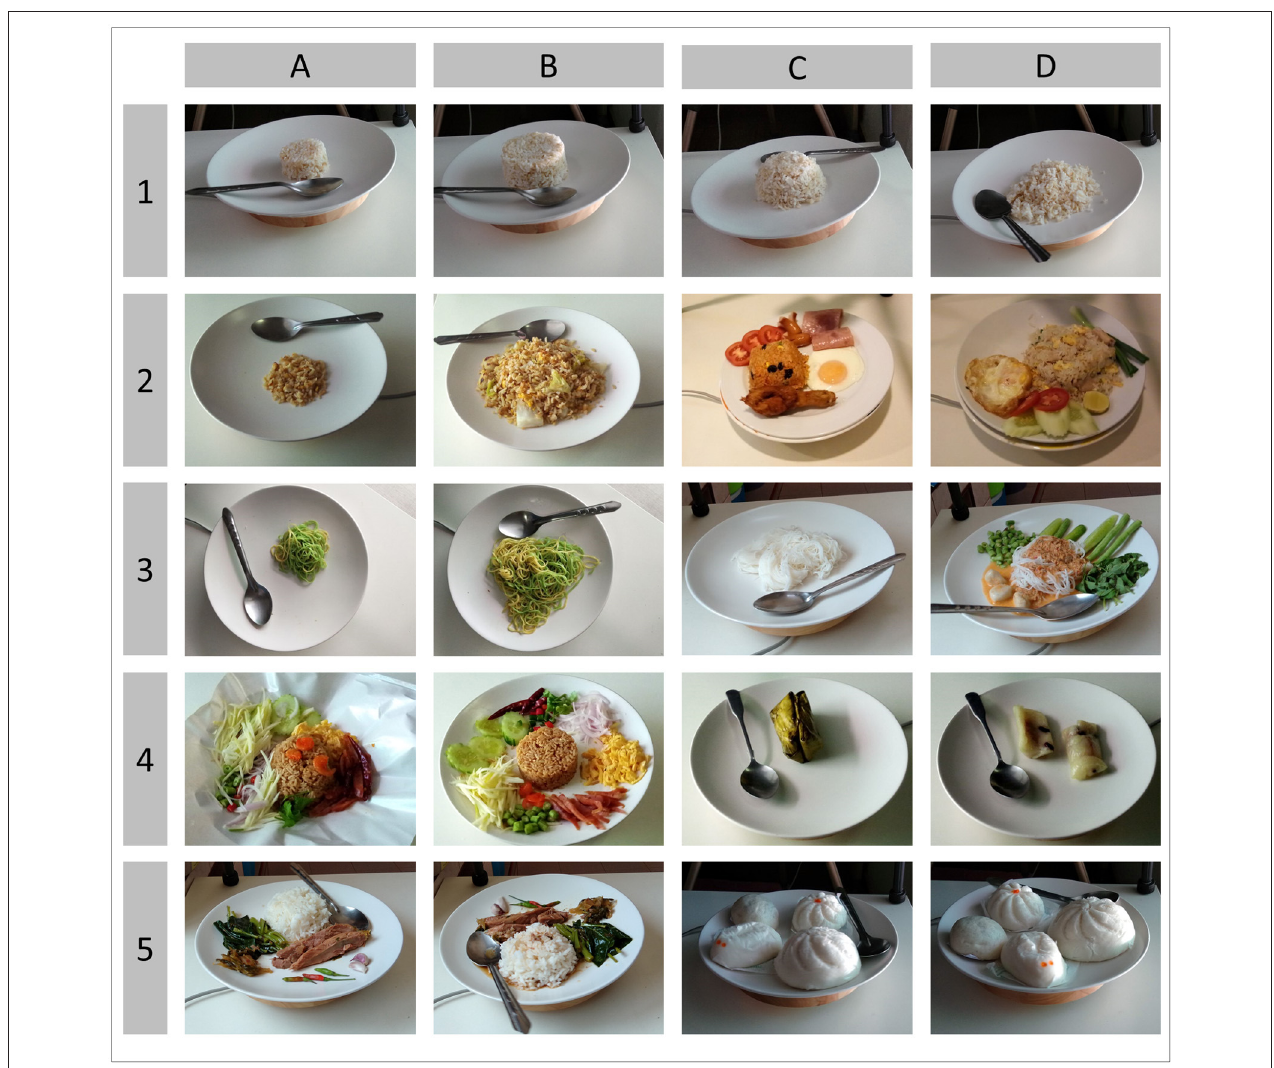
FIGURE 4 | Examples of Thai food images in the newly developed dataset; (A1:D1) represent gradual increases in the portion size of steamed white rice; (A2:D2) represent variation in visual appearance of (A2:B2) fried rice entailing plain fried rice, (C2) fried rice with ketchup and raisins, and (D2) fried rice as provided by food vendors; (A3:B3) are wheat noodles in gradually increasing portion sizes; (C3) is plain Kanomjeen (rice noodle), and (D3) is Kanomjeen topped with Namya-pla (ground fish in spicy coconut milk curry) and vegetables; (A4) is food vender prepared Khao-kluk-kapi (fried rice with shrimp paste), while (B4) is the rearranged form of the food as recommended for carbohydrate counting. (C4) is Kaotom-mud (glutinous rice steamed with coconut milk) wrapped in a banana leaf container, and (D4) is the unwrapped form of the dessert; (A5:B5) are steamed white rice with Ka-moo-palo (pig leg in a sweet stew), and (C5:D5) are various shapes of steamed buns, representing relocation of food items due to plate